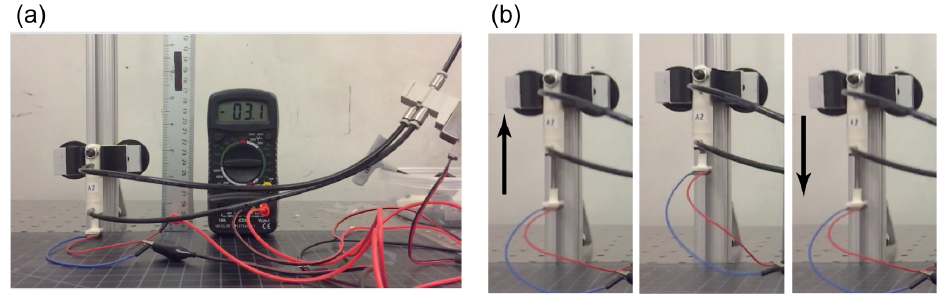
Figure 7. ( a ) Experimental setup to measure peak output force and peak output power for the actuator. ( b ) Actuator performing a successful